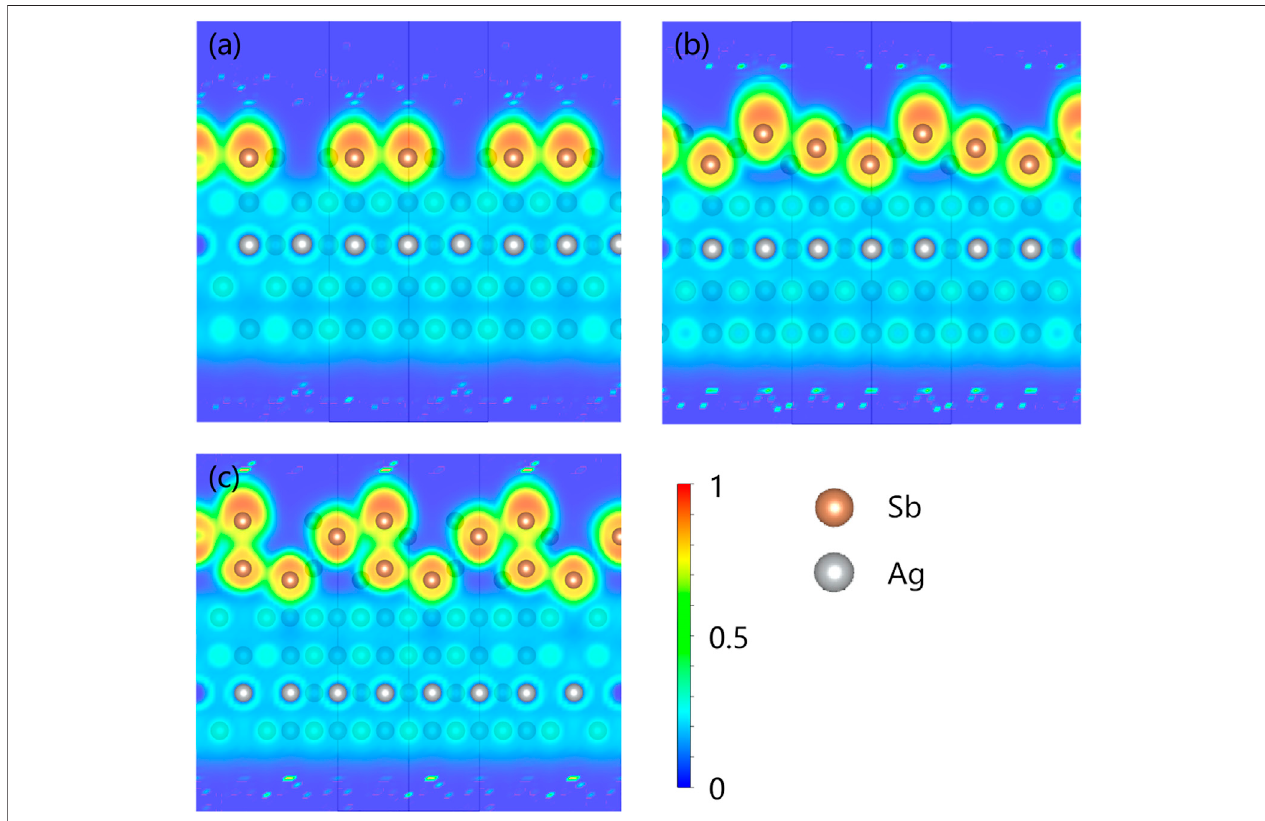
FIGURE 3 | 2D contour plot of the electron localization function (ELF) of the Sb atoms on a pure Ag (111) substrate at C Sb = (A) 2/3, (B) 3/3, and (C) 4/3 along the cut of the Miller index (110). The minimum ELF value is 0.0 (blue) and the maximum value is 1.0 (red). The brown and silver balls represent Sb and Ag, respectively.